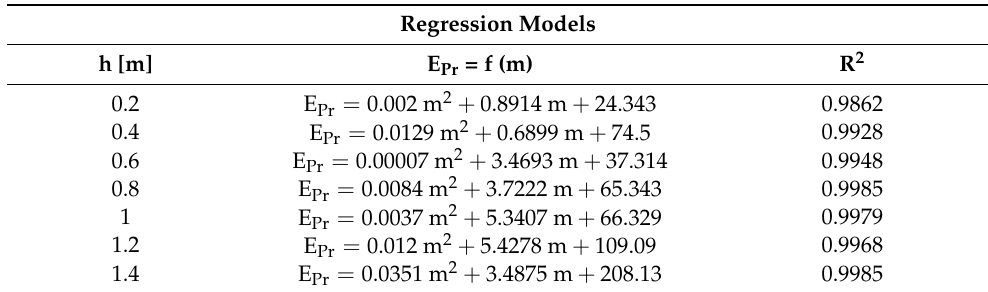
Figure 14. The correlation between the impact energy E Pr and the hammer mass m (the pyramidal impactor) for impact heights h in meters: ( a ) a 3D area chart; and ( b ) a surface chart. Table 5. Regression models of impact energy E Pr [J] for individual impact heights h [m] using the spherical impactor with hammer mass m [kg] for interval 50–100